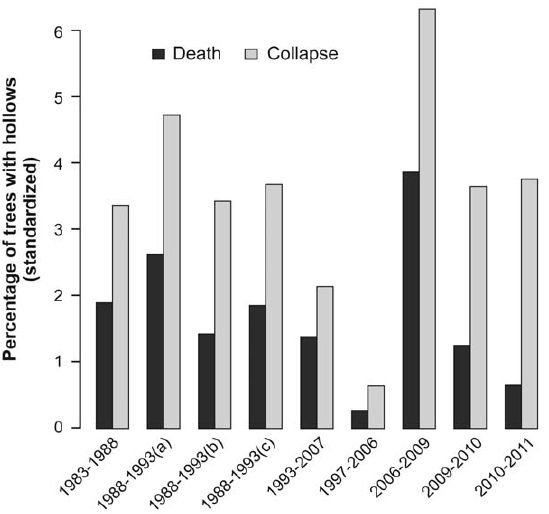
Figure 4. Historical death and collapse rates of trees on sites which did not experience wildfire in 2009. Note (a) corresponds to a dataset comprised of 286 large trees with cavities on 29 sites measured in 1988 and1993, (b) refers to 744 large trees with cavities measured on 109 sites in 1988 and 1993, and (c) corresponds to a dataset comprised of 399 large trees with cavities on 49 linear